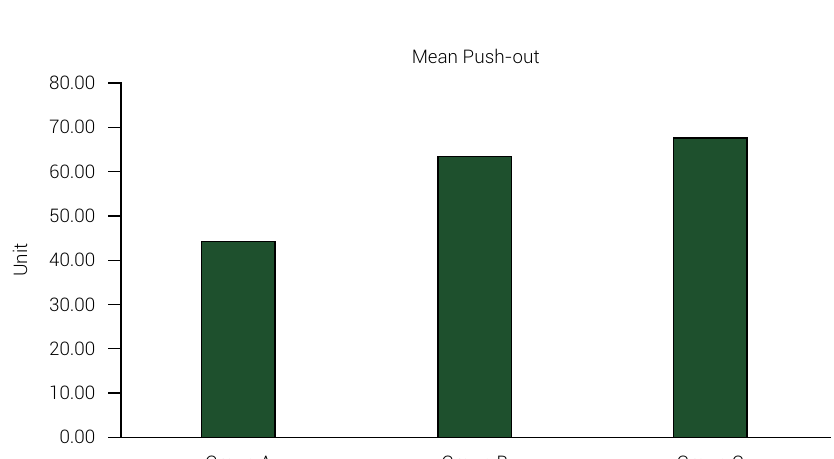
Figure 4. Bar chart representing the mean push-out in the middle third in the three groups.